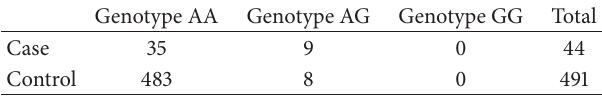
Figure 2: Linkage disequilibrium heat map near SNP rs2377339 on chromosome 2. Table 3: Allele counts of rs2377339 in cases (opiates dependence) and controls (nonopiates dependence) in African-origin